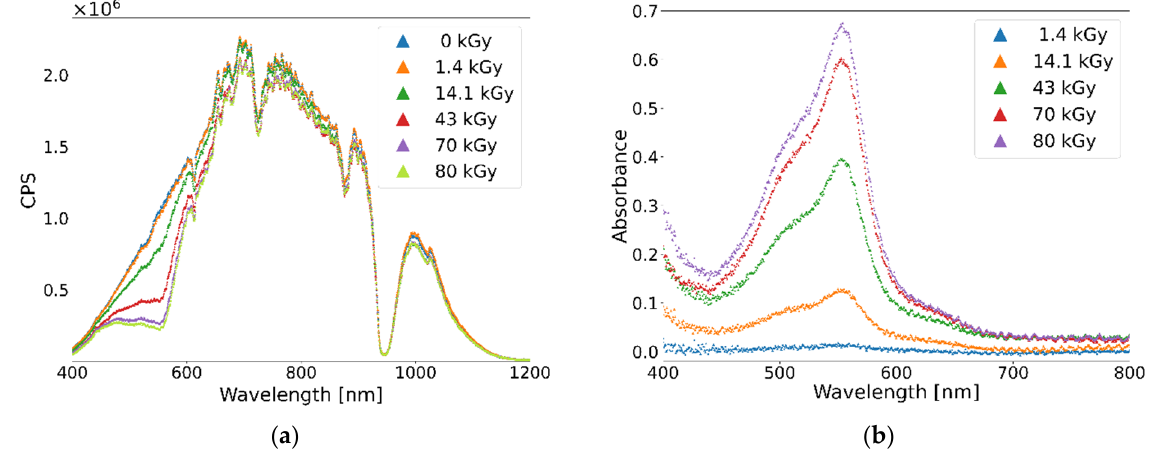
Figure 4. Reflection ( a ) and absorbance spectra ( b ) of Risø B3 film exposed to different doses from a 1.02 MeV electron scanned beam. The dose was measured by monitoring the flux of the electrons on an aluminum plate placed at the same position as the dosimeter.